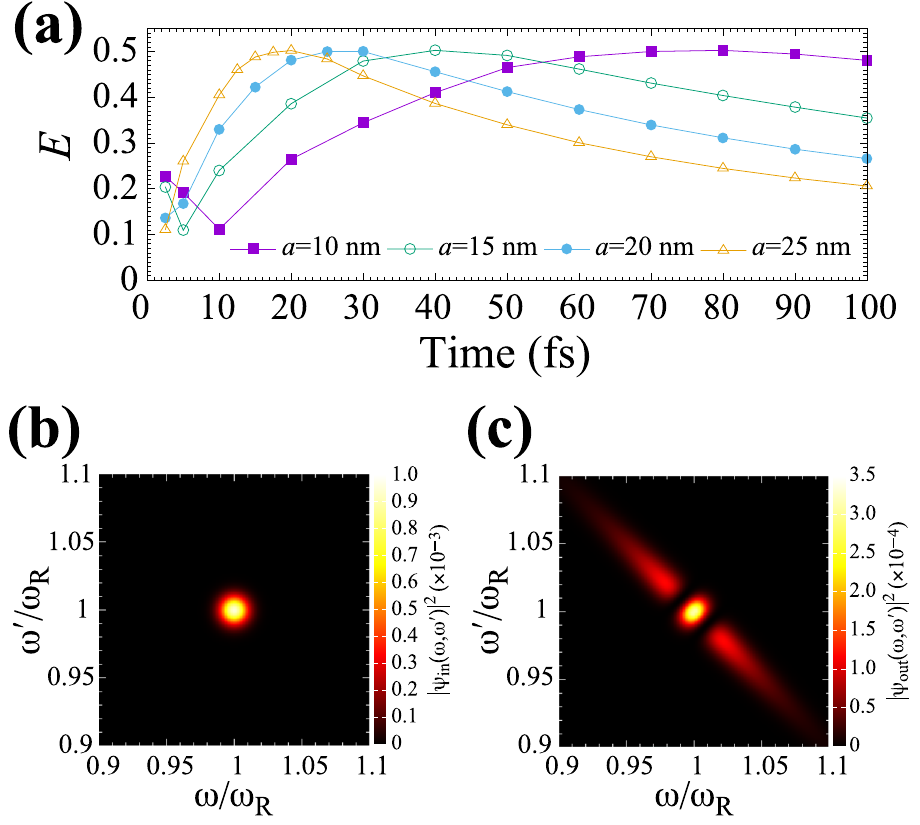
2 with σ = 20 fs. in